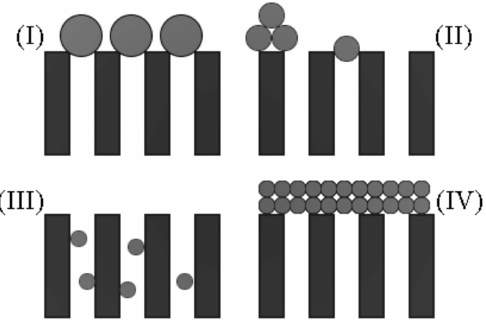
Figure 1. Blocking mechanisms by Hermia (1982): ( I ) complete blocking; ( II ) intermediate blocking; ( III ) standard blocking; ( IV ) cake formation. Table 1. Application examples of the Hermia